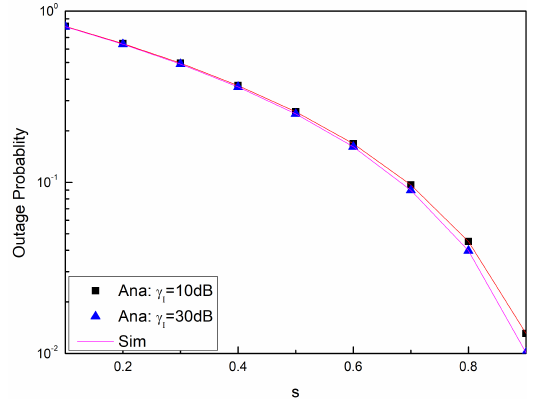
Figure 4. The impact of backhaul reliability on system performance (K=3)